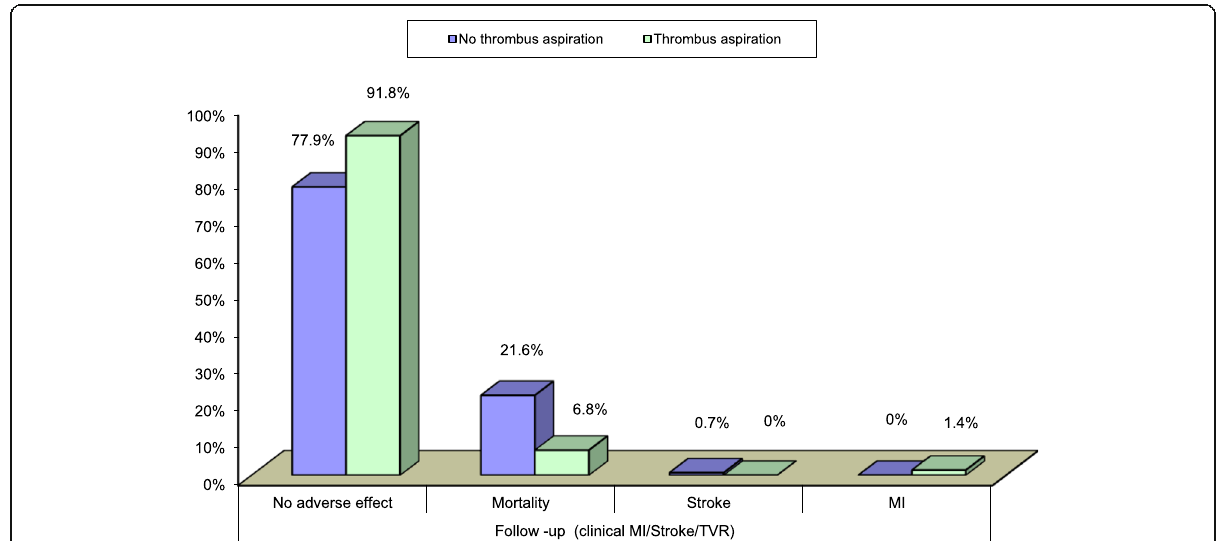
Fig. 2 Statistical significant difference between the 2 groups regarding MACE at 1 month follow-up